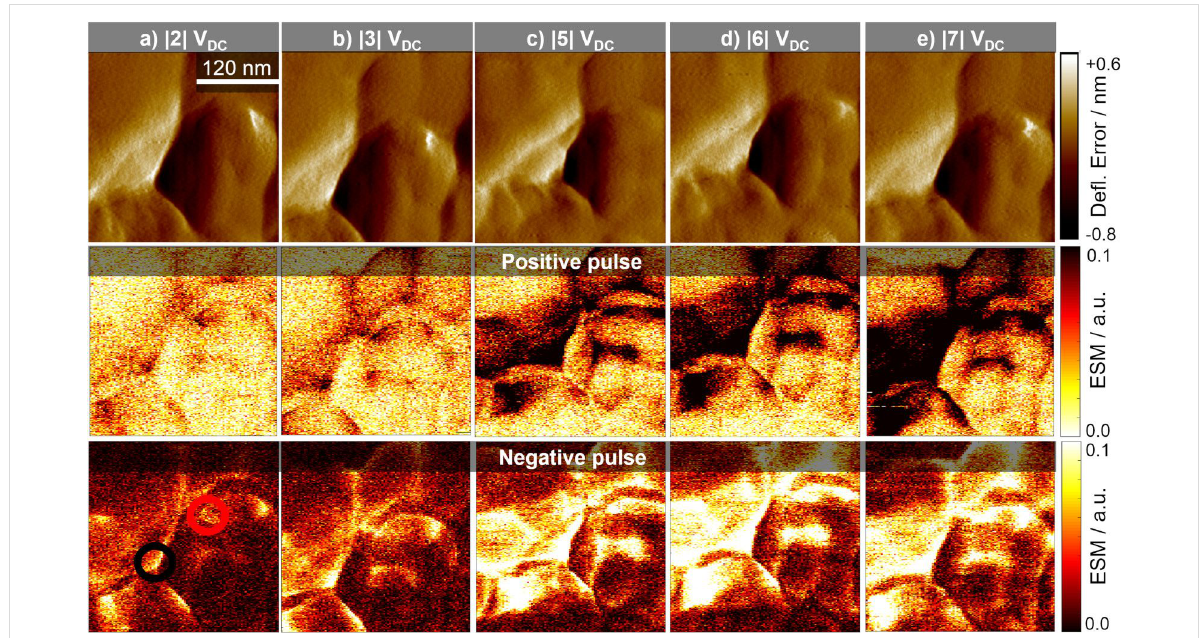
Figure 3: Comparison of different dc-voltage amplitudes at the same location of a fresh cathode. The top row shows the deflection error, the middle row the ESM signal during positive dc-pulse and the bottom row during negative dc-voltage pulse. In a) with |2| V, b) with |3| V, c) with |5| V, d) with |6| V and e) with |7| V. Scan size is 0.33 × 0.33 µm 2 .